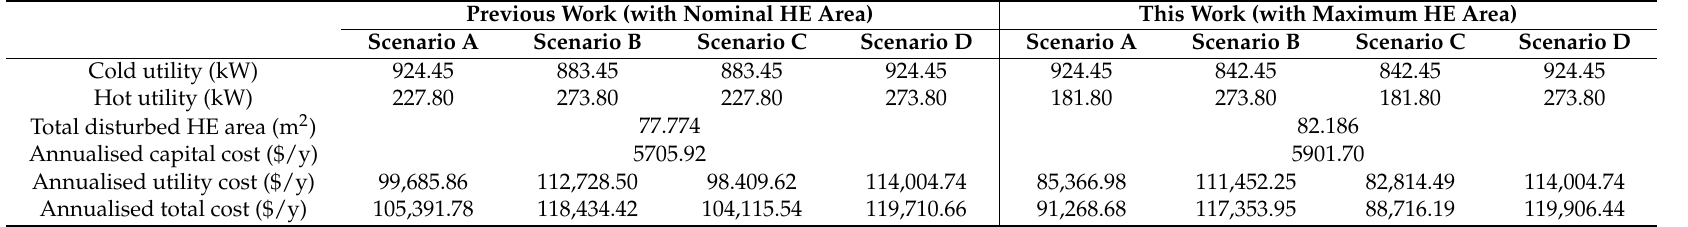
Table 9. Comparison results of HEN total annual cost for Case Study